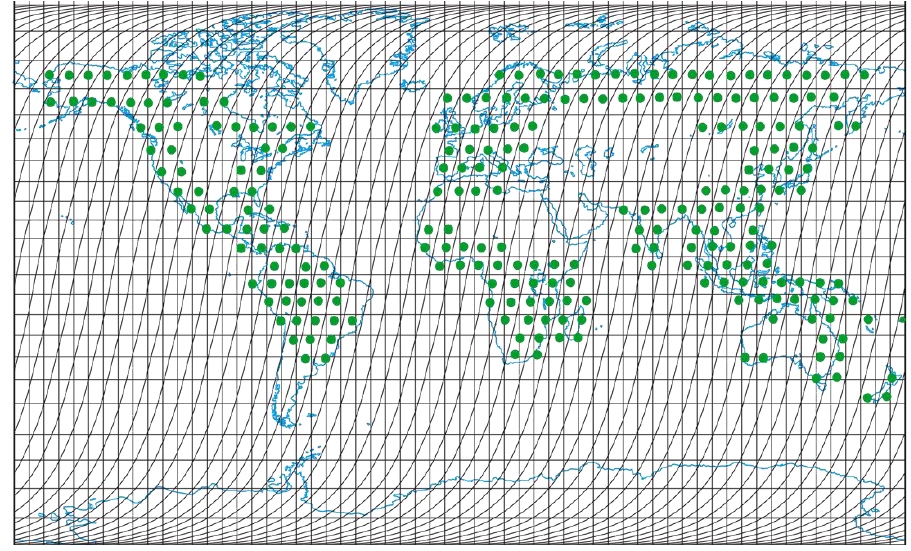
Figure 1. The distribution of global forest area and the path-row matrix of Landsat satellite images.